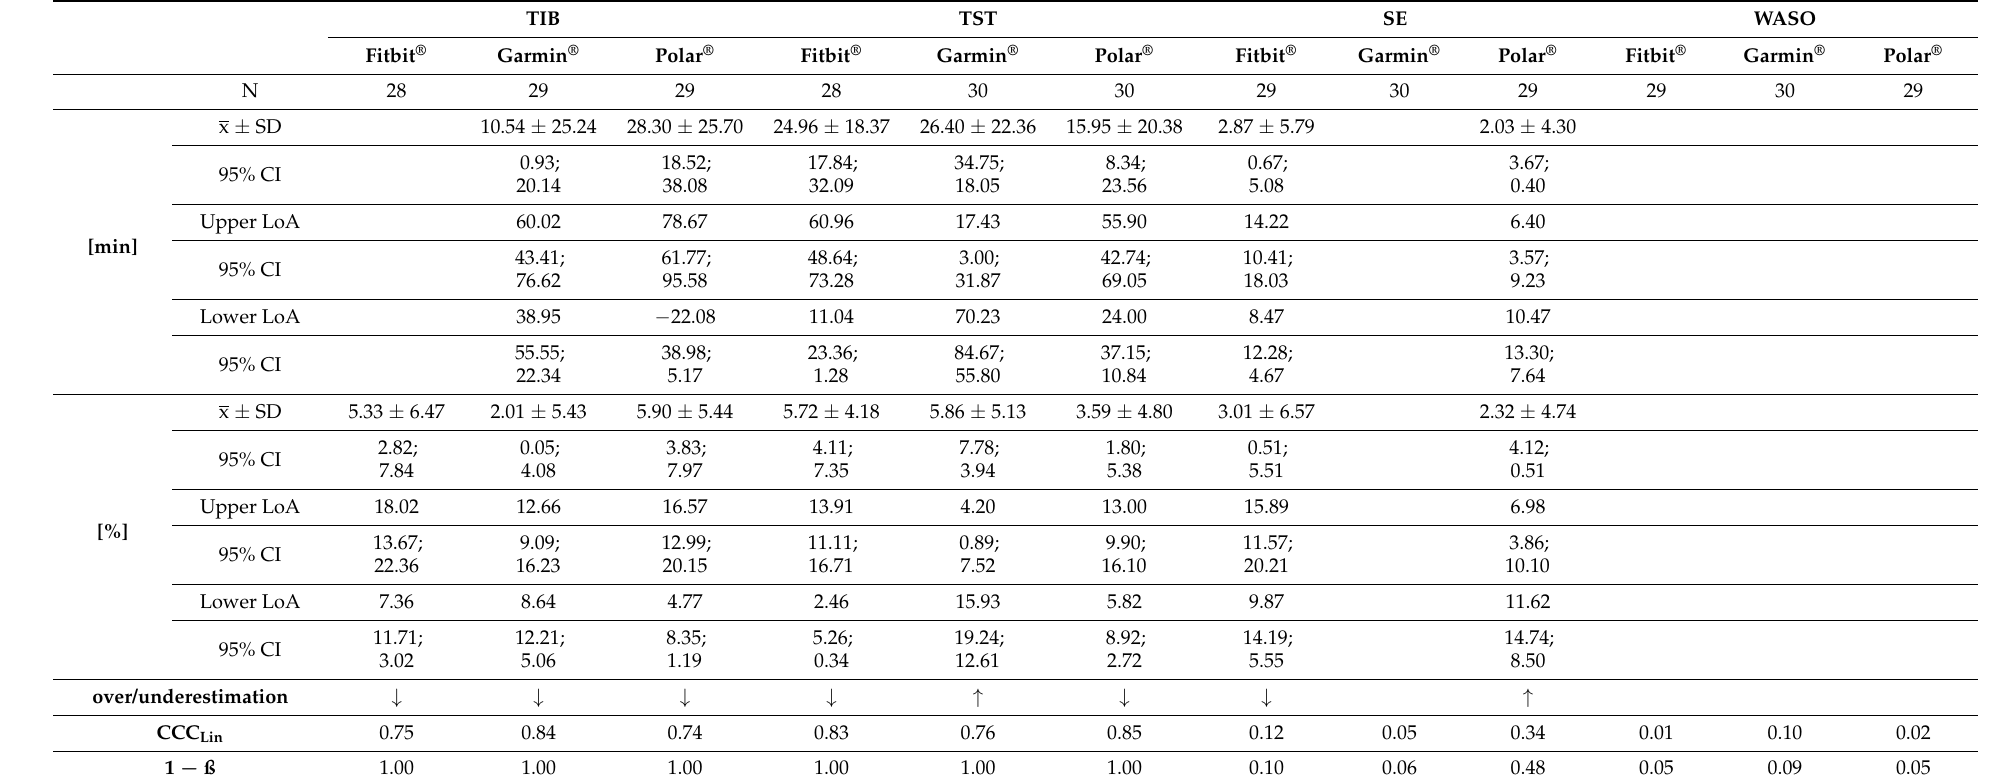
Table A1. Overview of agreement between wearables and diary (outliers